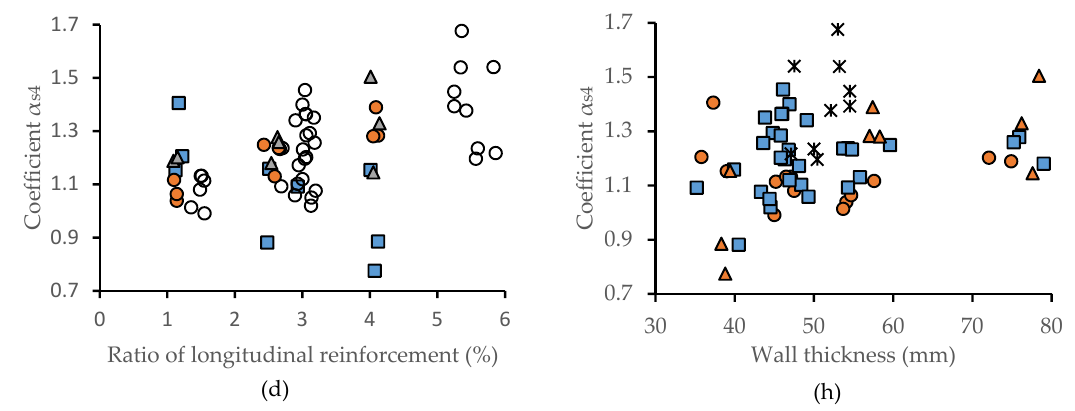
Figure 5. Coe ffi cients α s 1 , α s 2 , α s 3 , α s 4 dependence on ( a , b , c , d ) the ratio of longitudinal reinforcement µ s and ( e , f , g , h ) wall thickness t, while the spiral pitch s=100 mm.